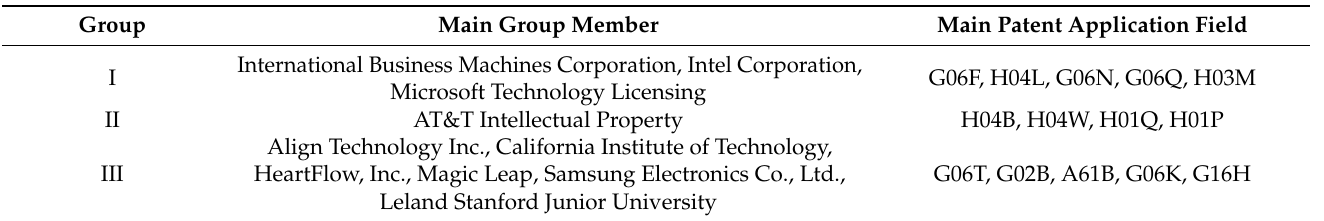
Table 4. Main members of each group.